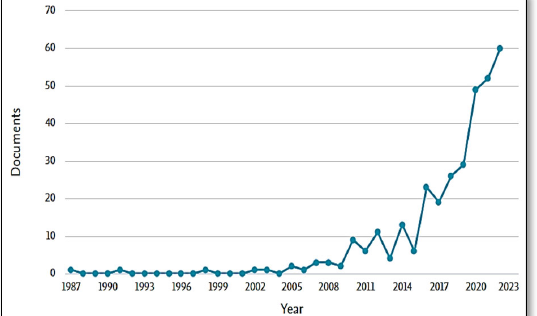
Fig. 3a. The number of documents published referring to each year of the words intelligence”, “artificial”, for “management”, “resource” and “Hydric” Source: Obtained from